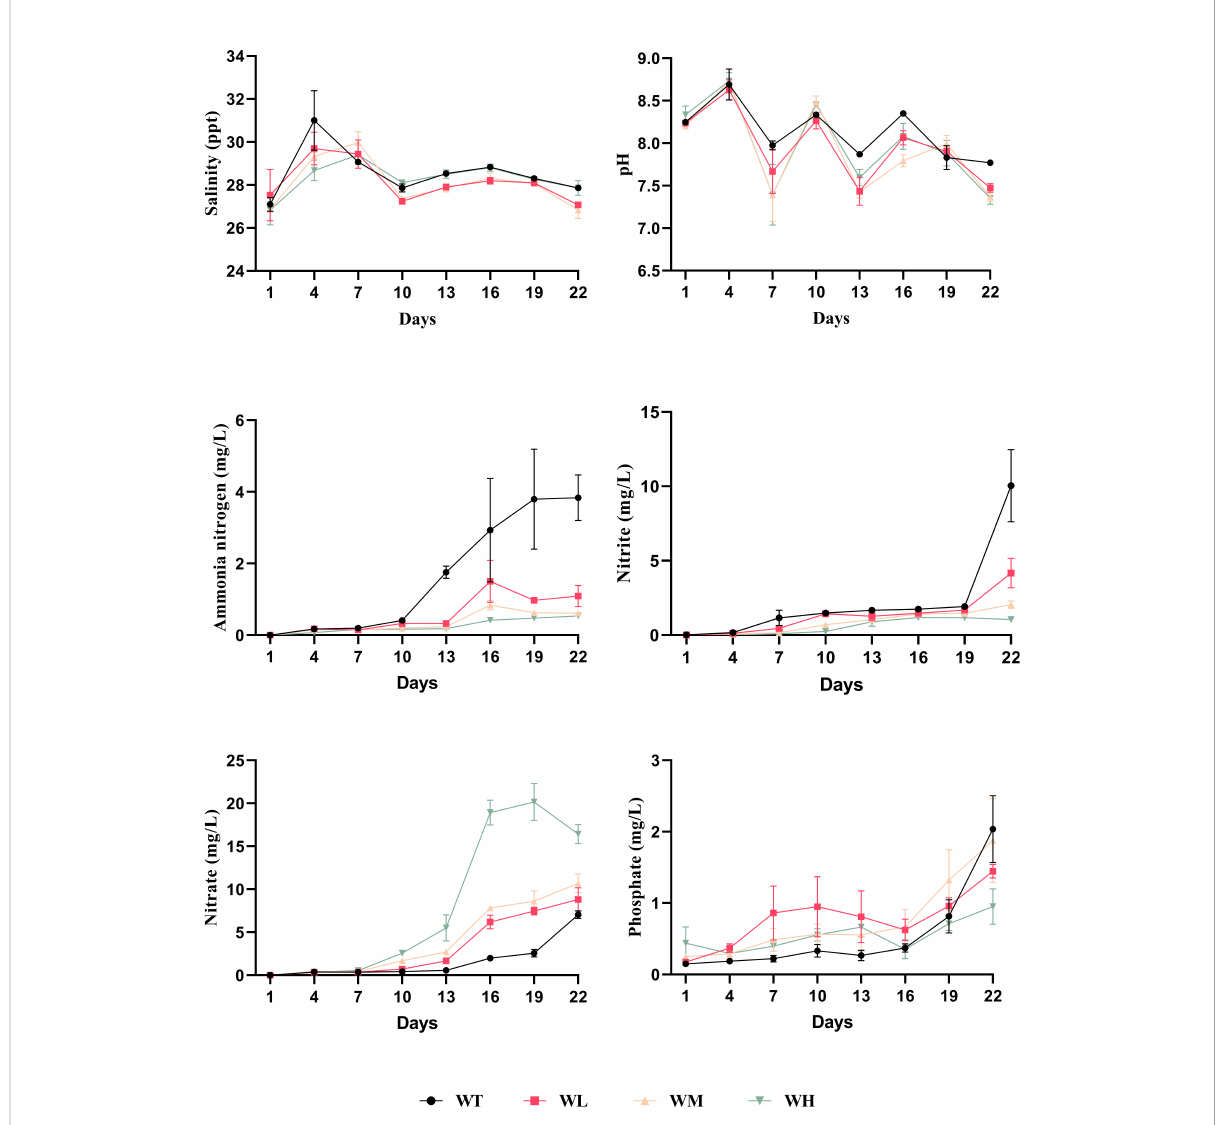
FIGURE 1 Combined line graph of the water quality parameters within 22 days of the experiment detected at 3-day